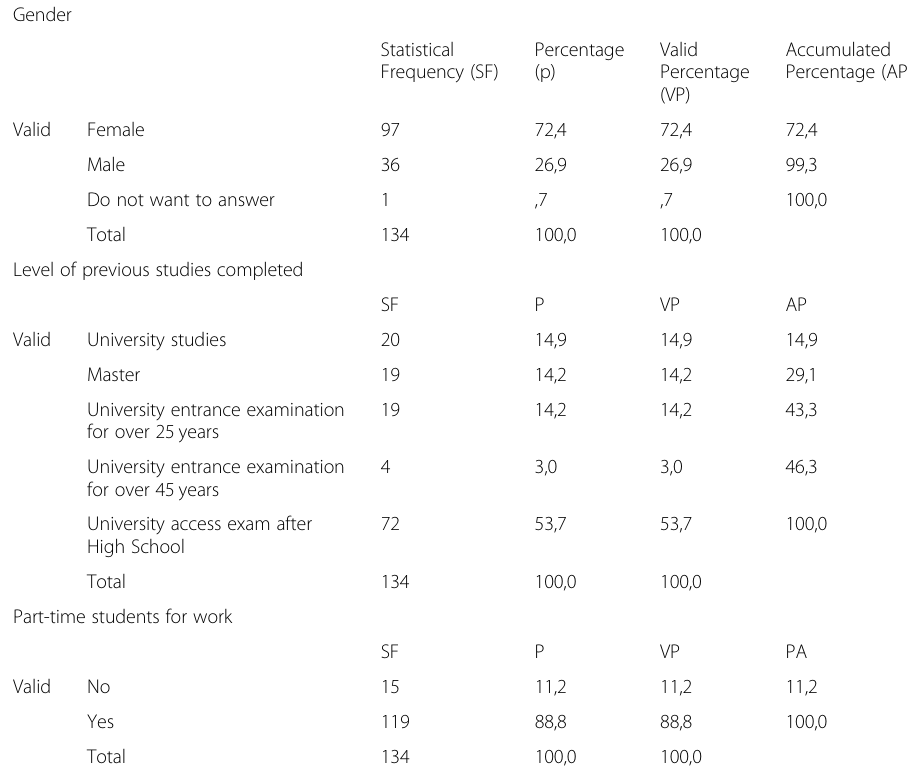
Table 1 Sociodemographic